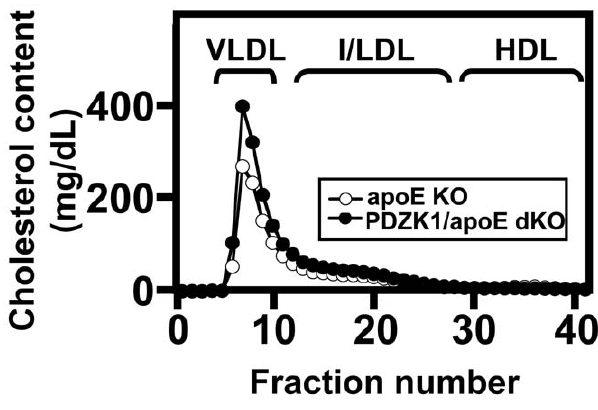
Figure 2. Lipoprotein cholesterol profiles from apoE KO and PDZK1/apoE dKO mice. Plasma harvested from individual mice fed a Paigen diet for three months was size fractionated using FPLC, and the total cholesterol contents of the fractions (mg/dL plasma) were determined by enzymatic assay. Profiles averaged from 2 independent experiments for each genotype, each composed of pooled plasma from six apoE KO (open circles) and six PDZK1/apoE dKO (filled circles) mice per experiment are shown. Approximate elution positions of human VLDL, IDL/LDL and HDL are indicated.